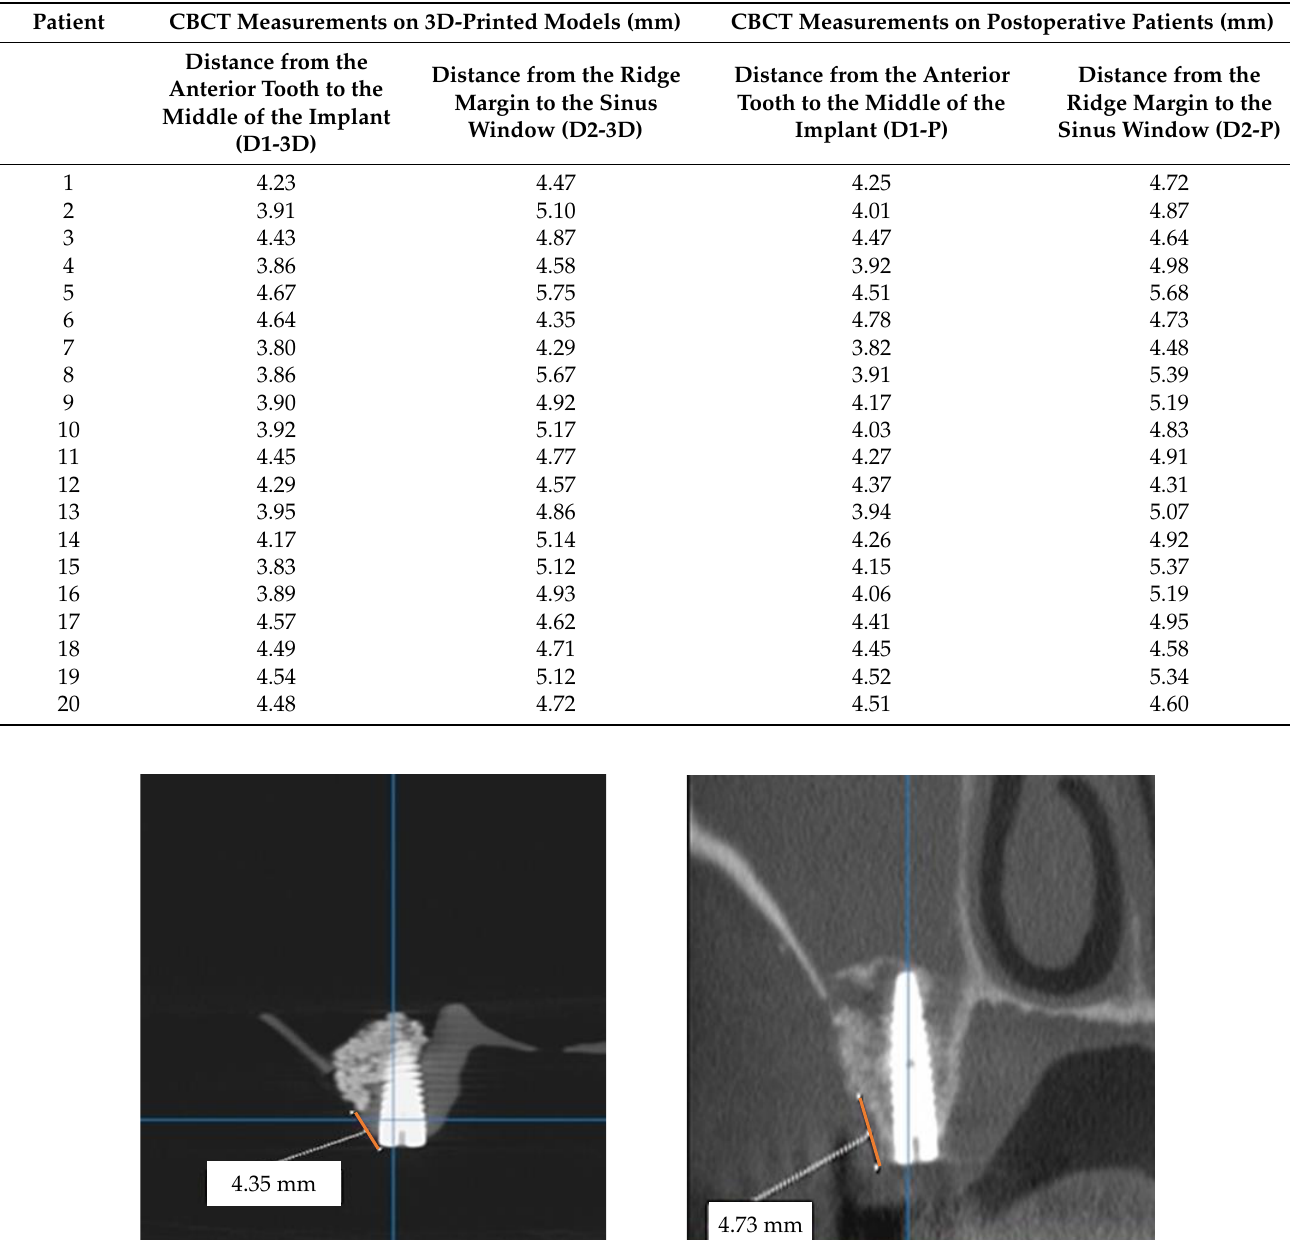
Table 1. Measurements performed on CBCT images: 3D-printed models (rehearsed procedures) versus patients (postoperative). Patient